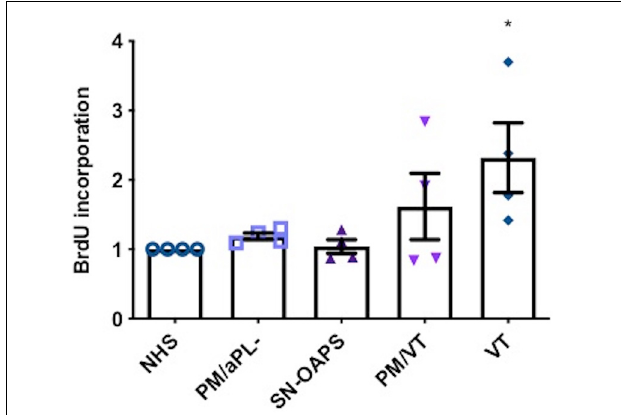
FIGURE 4 | Endothelial cell proliferation is increased by aPL. HUVECs were stimulated with polyclonal IgG (250 µ g/ml) from women with clinical features of APS (SN-OAPS; PM/VT; and VT) and control groups (NHS and PM/aPL-). Cell proliferation was measured by BrdU incorporation. The chart shows that VT IgG significantly increased cell proliferation in comparison with NHS IgG. n = 4; * p < 0.05 vs. NHS as determined by one-way ANOVA and Holm-Sidak’s